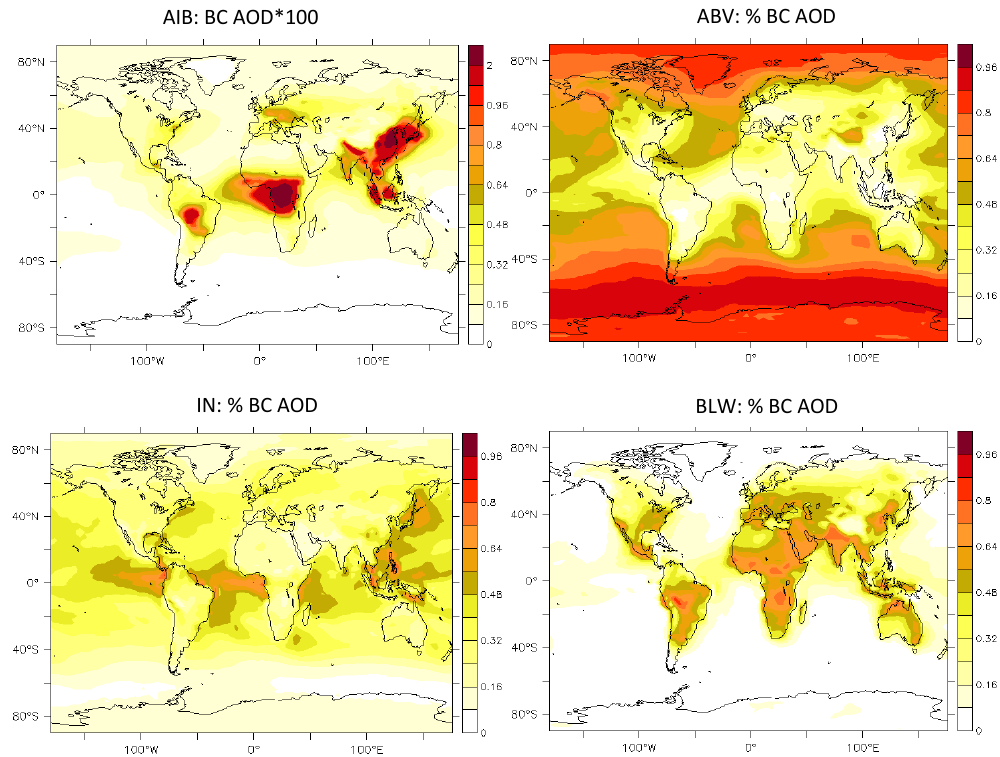
Fig. 3. BC optical depth distribution: BC AOD ∗ 100 for the AIB experiment (top left), percentage of BC AOD above clouds (ABV experiment, top right), percentage of BC AOD inside clouds (IN experiment, bottom left) and percentage of BC AOD below clouds (BLW experiment, bottom right).